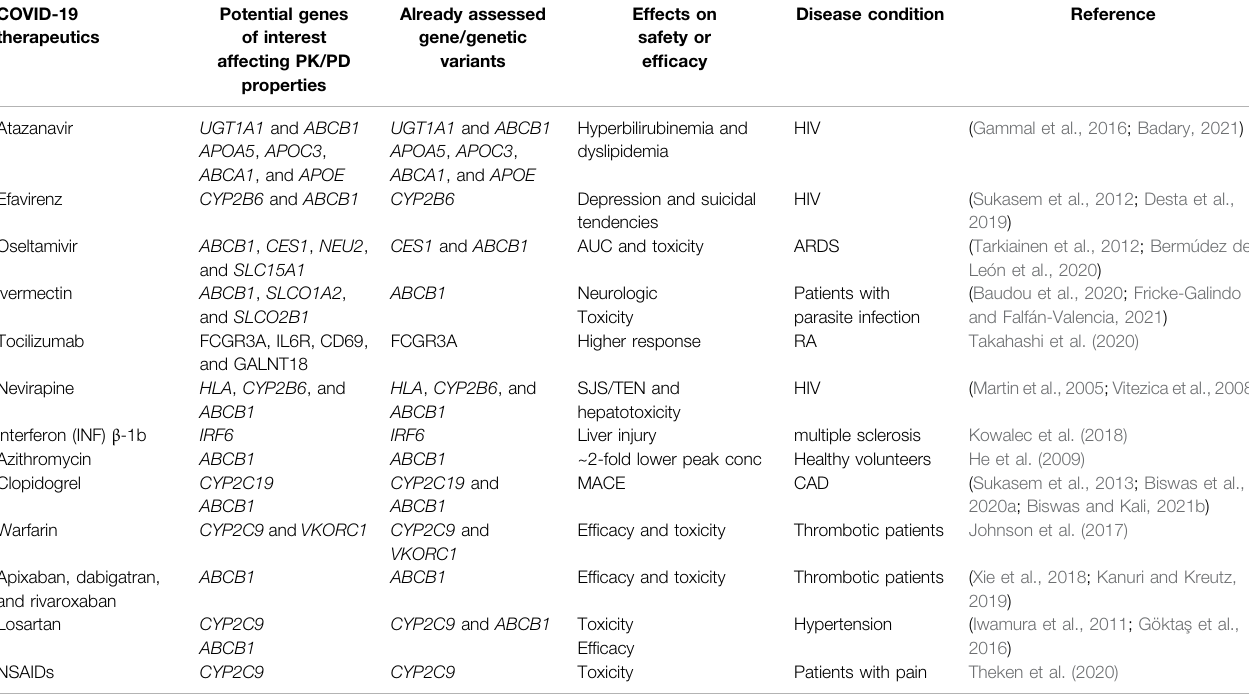
TABLE 3 | Summary of the pharmacogenomic studies affecting the safety or ef fi cacy of COVID-19 therapeutics in other clinical conditions. COVID-19